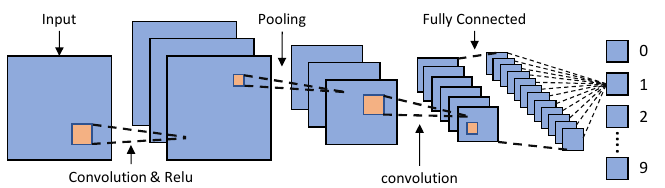
Figure 7. General CNN